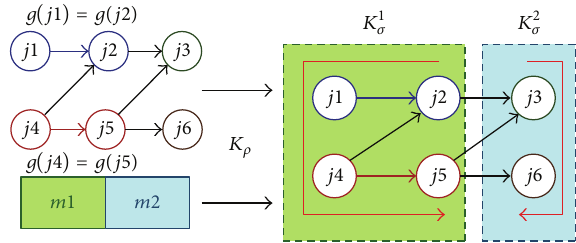
Figure 2: Partitioning and scheduling